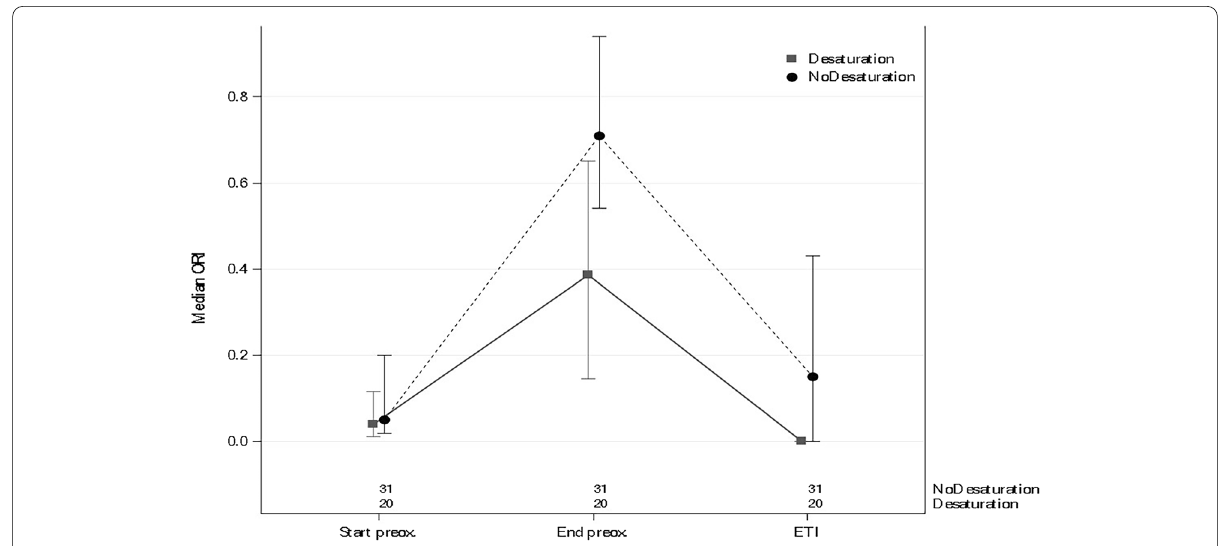
Fig. 2 Changes in oxygen reserve index (ORI) in patients with and without hypoxemia during endotracheal intubation (ETI)